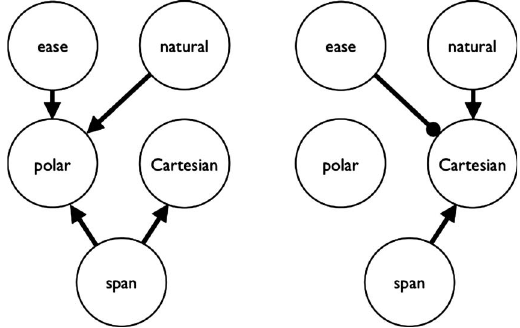
FIG. 5. Resource graph of Wes and Derek from the week 4 miniview. Note the explicit lack of connection between ease of calculation and Cartesian resources for Wes but not for Derek. Only natural, ease, Cartesian, polar , and span